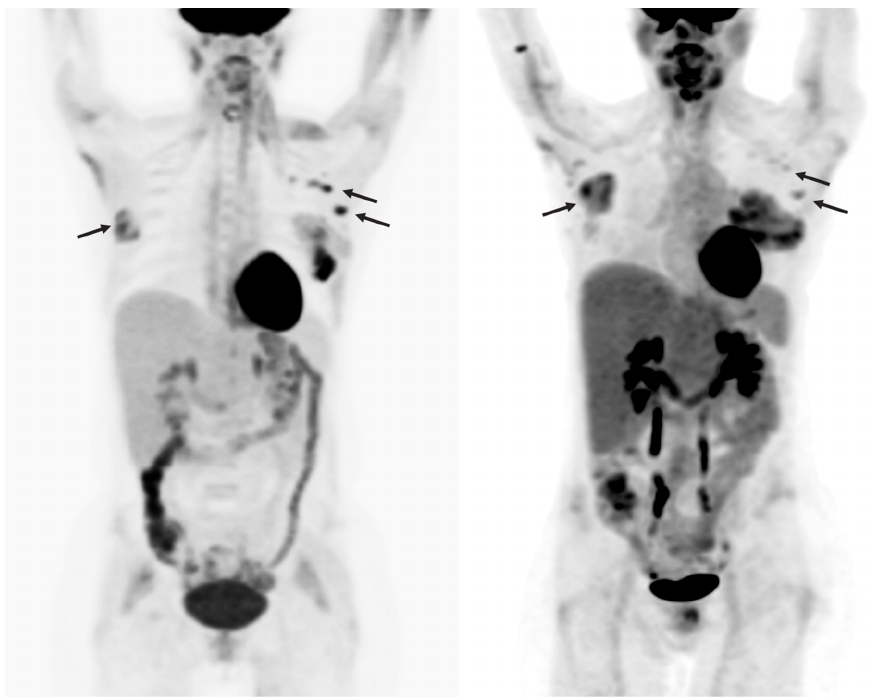
Figure 6. A 47-year-old woman with acute lymphoblastic leukemia and remote history of melanoma. Maximum intensity projection images pre- ( left ) and post- ( right ) CAR T-cell therapy showing new hepatomegaly with mild increased heterogeneous FDG uptake, with mixed changes in extramedullary leukemic involvement, increased in the right breast and decreased in the left axillary nodes.